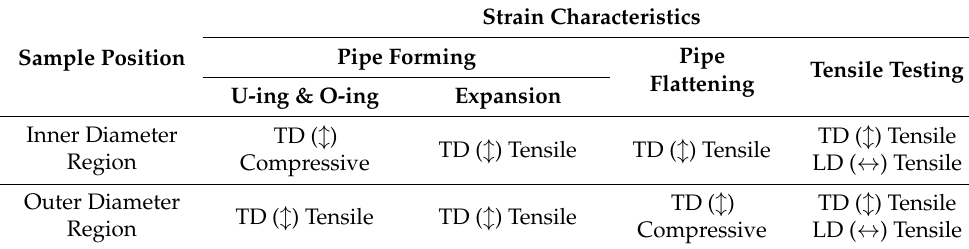
Table 2. Expected strain histories of the steel B and steel FP tensile test specimens for inner and outer region longitudinal (LD, ↔ ) and transverse (TD, ↕ ) specimens during UOE pipe forming (U-ing, O-ing, and expansion), pipe flattening, and tensile testing.